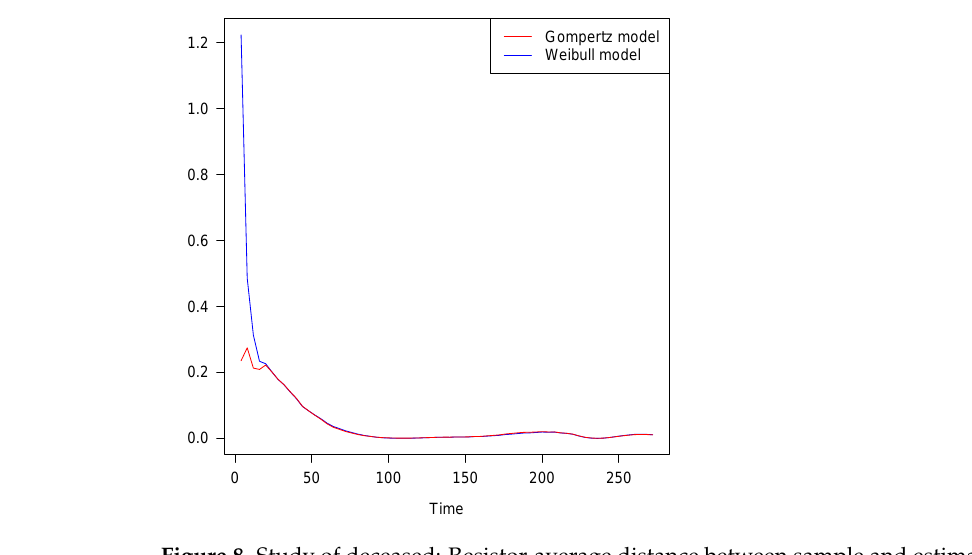
Figure 8. Study of deceased: Resistor-average distance between sample and estimated distributions as a function of time for the two estimated models.